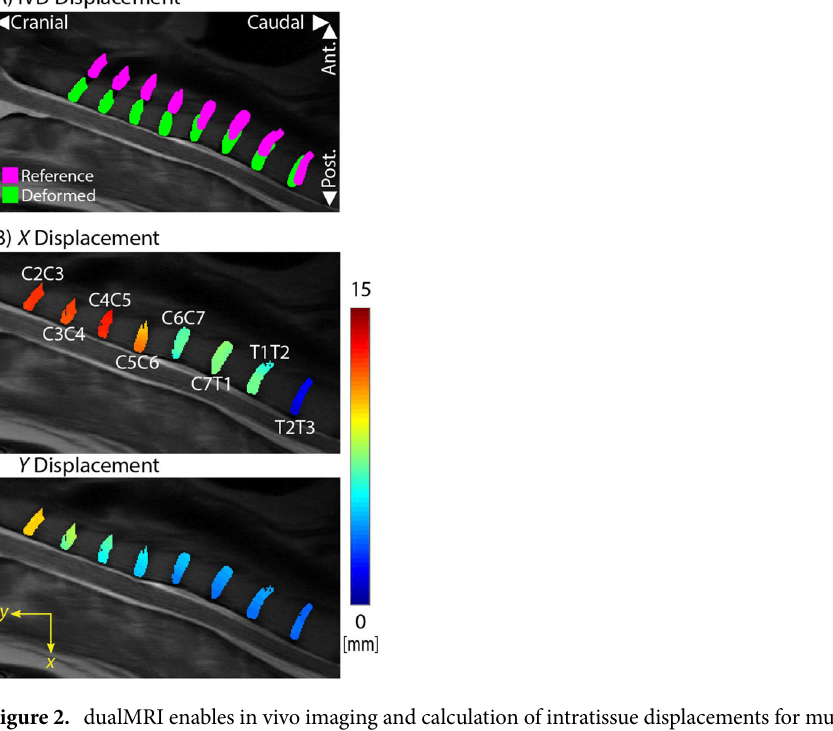
Figure 2. dualMRI enables in vivo imaging and calculation of intratissue displacements for multiple adjacent disc segments in a single subject. ( A ) IVD displacement is calculated from the flexed position (reference/ magenta) to the neutral (deformed/green) IVD position with dualMRI. Positive x and y displacements are in the posterior and cranial directions respectively. ( B ) Smoothed x and y displacements of the cervical and thoracic IVDs (C2C3–T2T3) shows intratissue deformations not available with traditional methods, which commonly assess only bulk (e.g. rigid body) motion of the tissue. Both x and y displacements caudally decrease with higher displacements in the x direction, indicating bending motion in the sagittal plane.